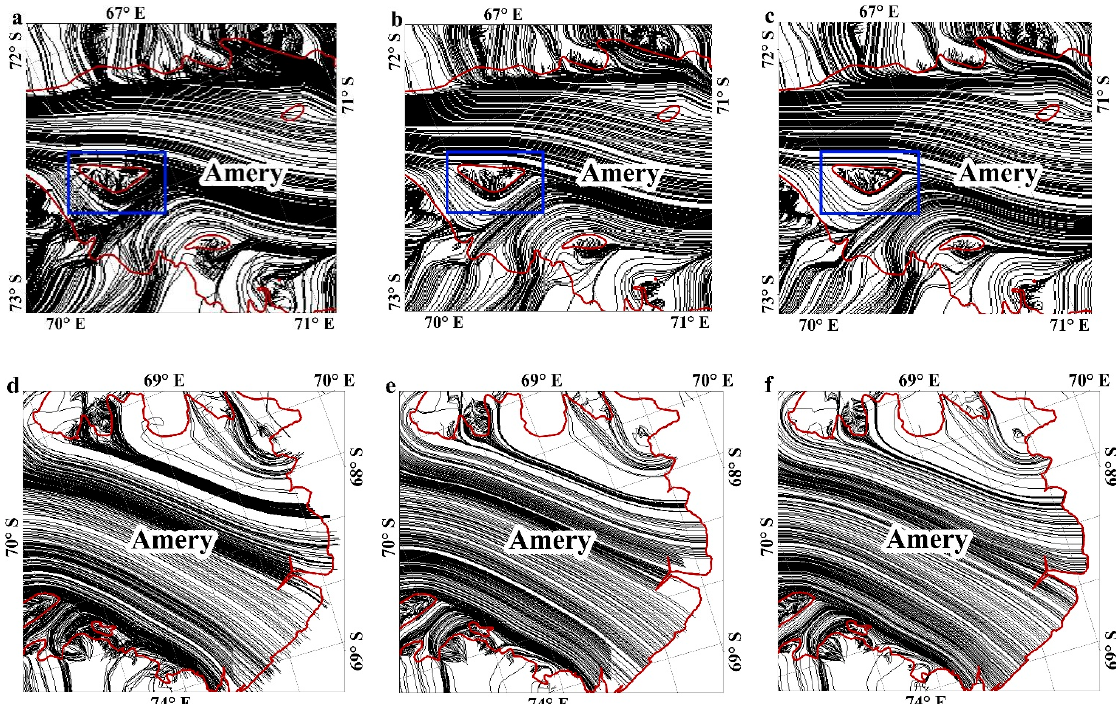
Figure 8. Comparisons of ice flow line extraction result on the partial Amery ice shelf. The black lines denote the derived ice flow lines, the red lines denote the boundaries of Amery ice shelf. ( a ) Method only considering angular difference (case #1). ( b ) Weight-balance-based method considering angular difference and distance difference (case #1). ( c ) Proposed method (case #1). ( d ) Method only considering angular difference (case #2). ( e ) Weight-balance-based method considering angular difference and distance difference (case #2). ( f ) Proposed method (case #2).